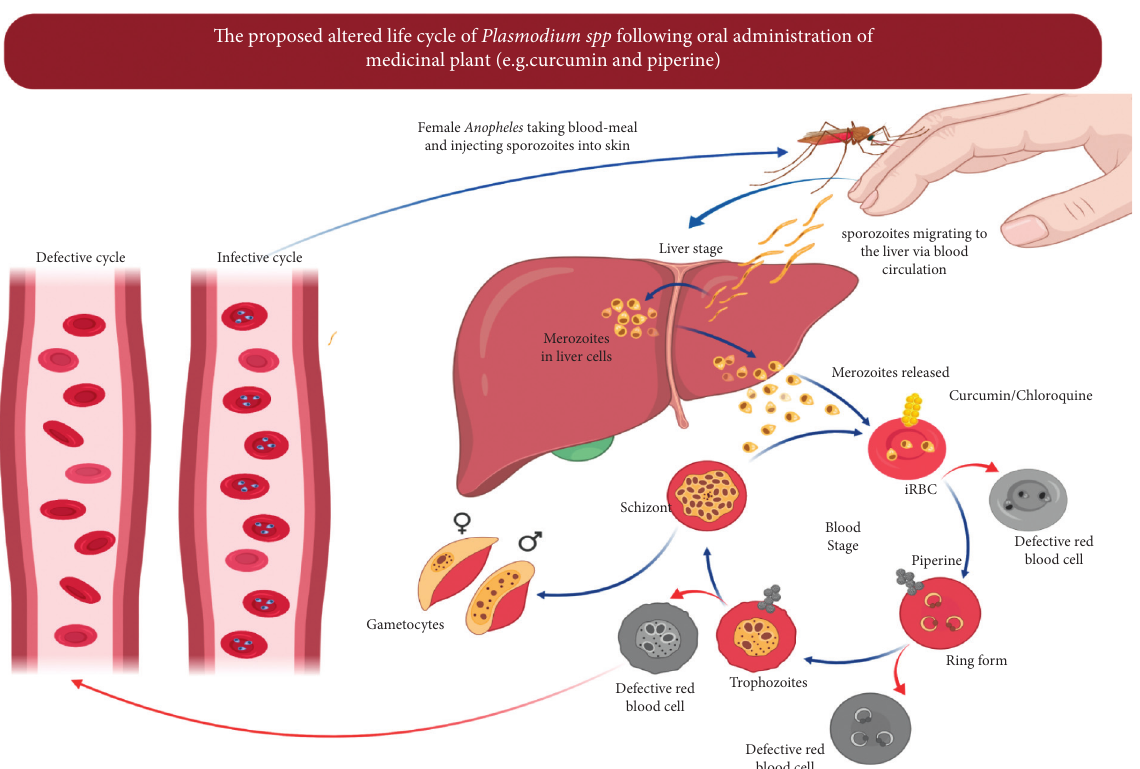
Figure 3: The proposed modification of the Plasmodium life cycle. The navy-colored arrows represent the normal infective life cycle, while the red-colored arrows represent the defective life cycle due to the action of the curcumin-piperine combination. There is a possibility that the parasite development was disrupted at the initial or late stages of red blood cells (defective red blood cells), so it cannot infect other red blood